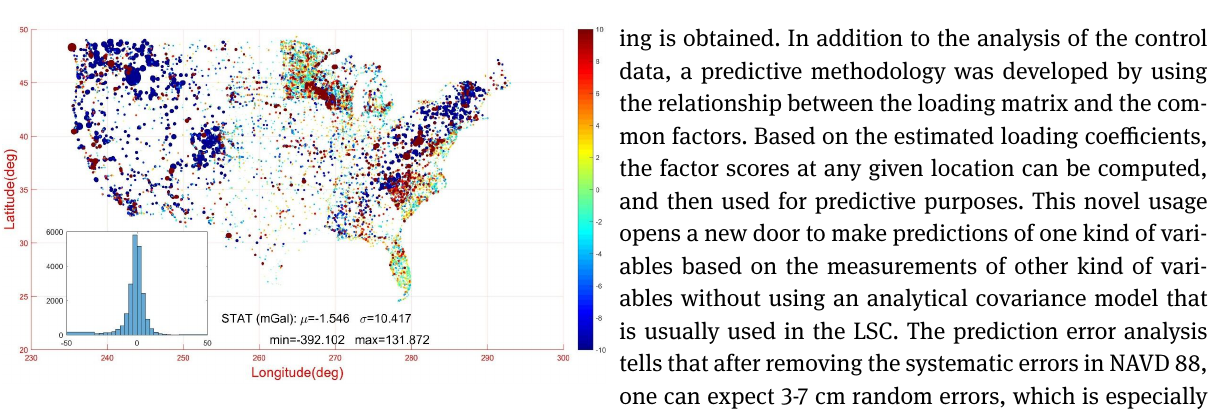
Figure 9: The gravity differences between NAVD 88 and XGeoid16refB at the NAVD 88 benchmarks (the size of the dot represents the magnitude with positive towards red and negative towards blue).